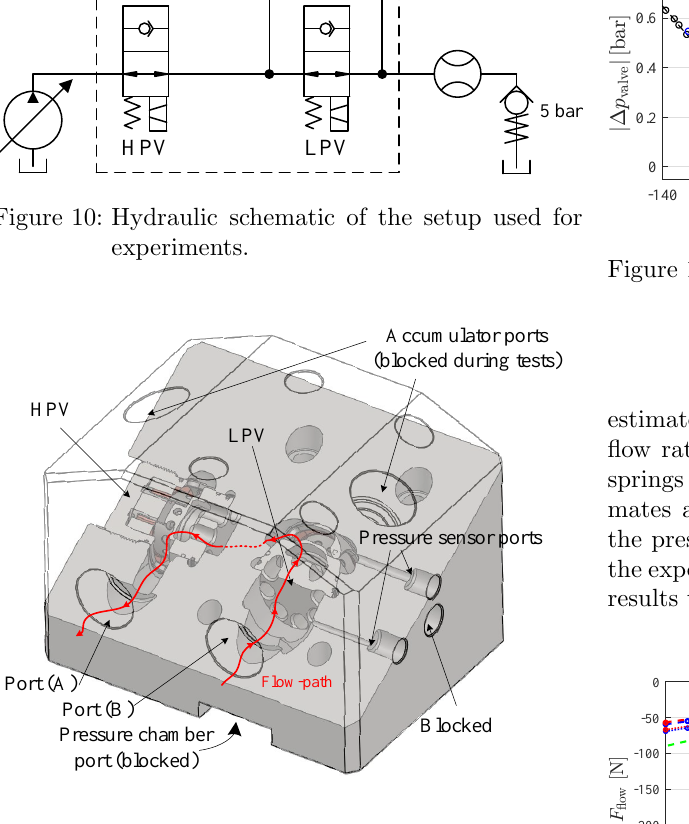
Figure 11: CAD-model showing the valve block used for experiments.